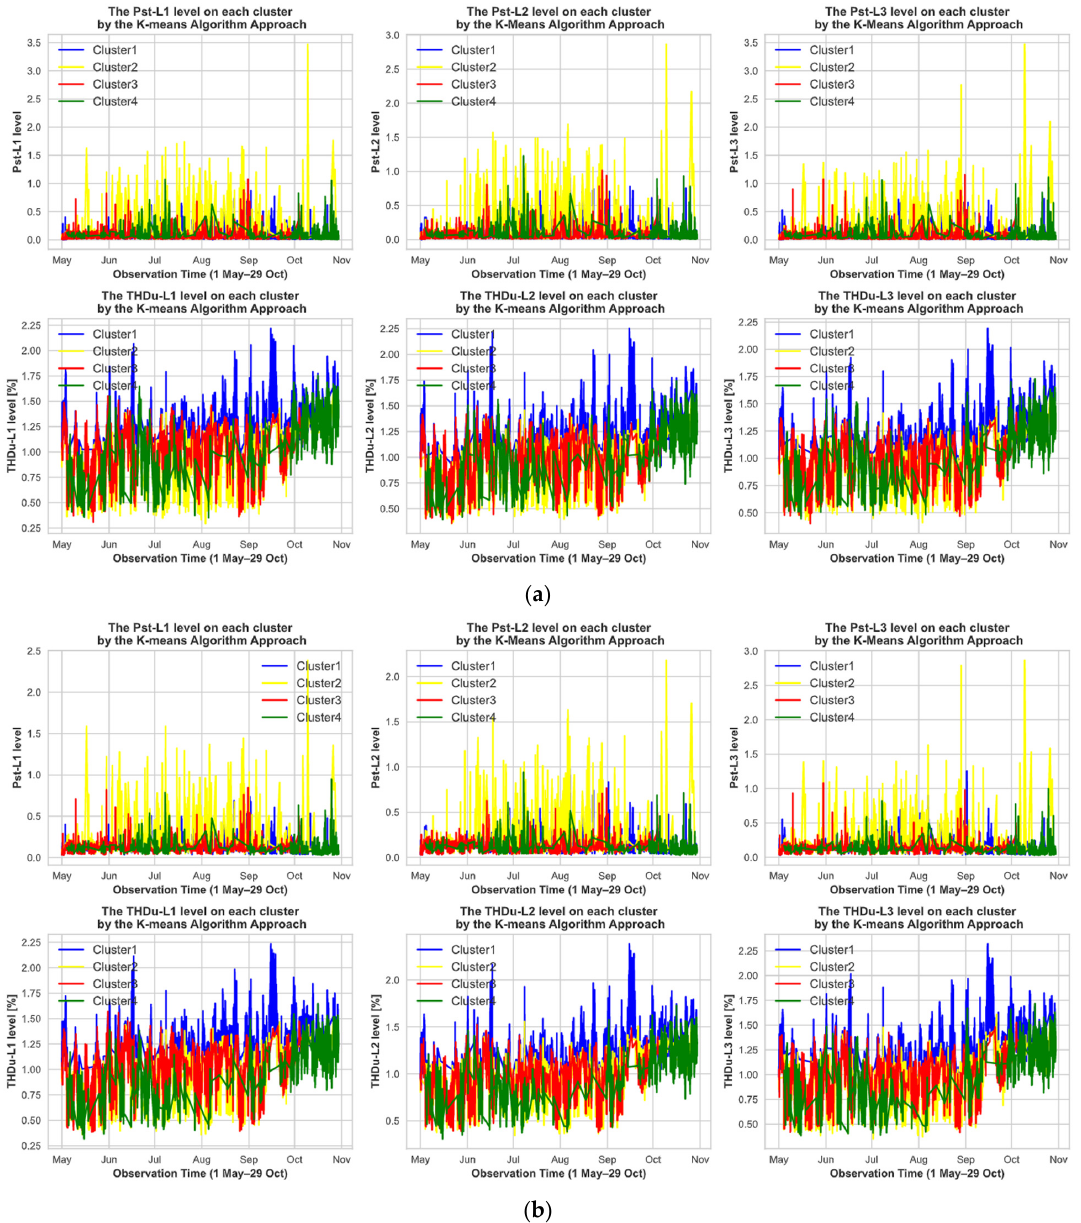
Figure 8. Visualization of PQ parameters’ level of the second investigation object by the K-means algorithm approach: Part ( a ) is a PQ level’s graph at measurement point 1-MV and part ( b ) is a PQ level’s graph at measurement points 2HPP-MV and 2ESS-MV.